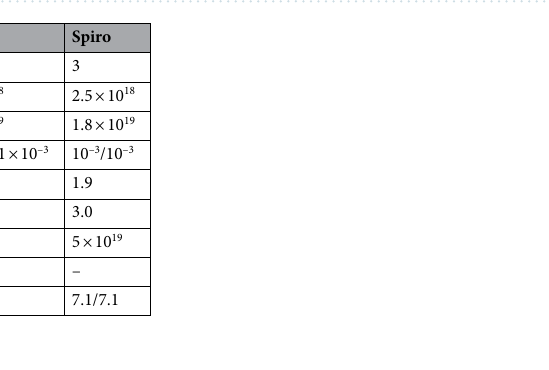
Figure 4. The multijunction PSC performance with and without rGO. ( a ) Current density–voltage (J–V) curve of the multijunction PSC performance with sprio and without rGO HTLs. ( b ) Current density–voltage (J–V) curve of the multijunction PSC with different HTL including Spiro, PTAA, rGO, and CuS. ( c ) Band alignment between the layers of multijunction PSC and the proposed HTLs.